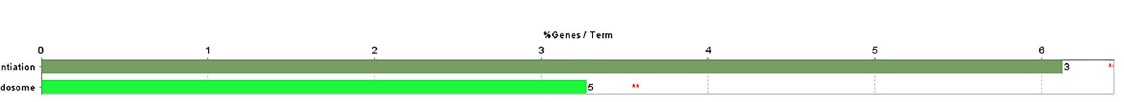
Figure 7. Results for enrichment analysis for target genes of gga-miR-1652: percentage of genes per significant